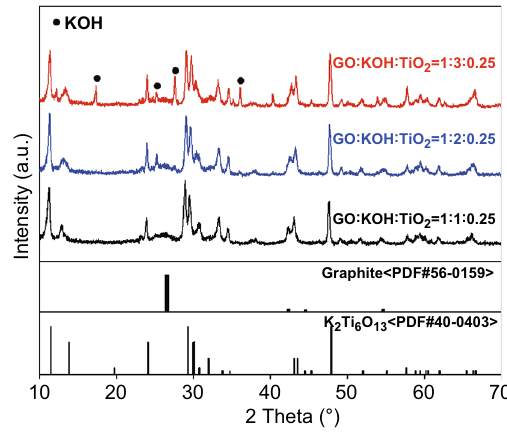
Fig. 2 X‑ray diffraction patterns of the KTO NP/PGC composites prepared at different weight ratios of GO and KOH (reaction tempera‑ ture: 200 °C, gas flow rate: 10 L min −1 , post‑heat treatment: 700 °C,